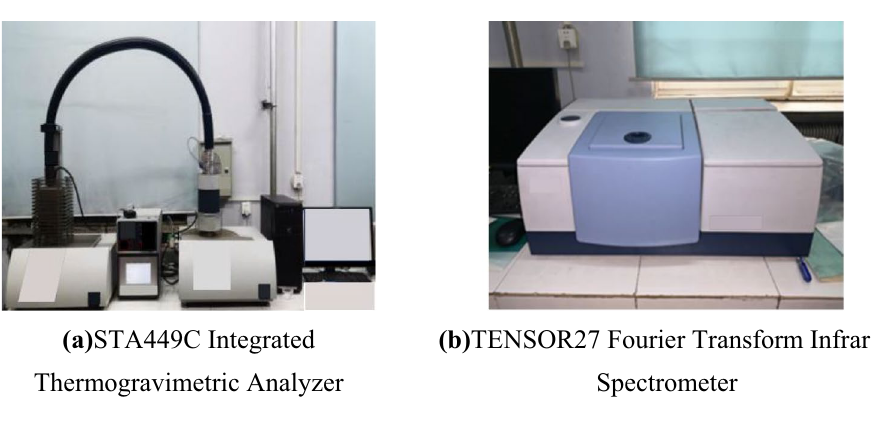
Figure 1. Experimental